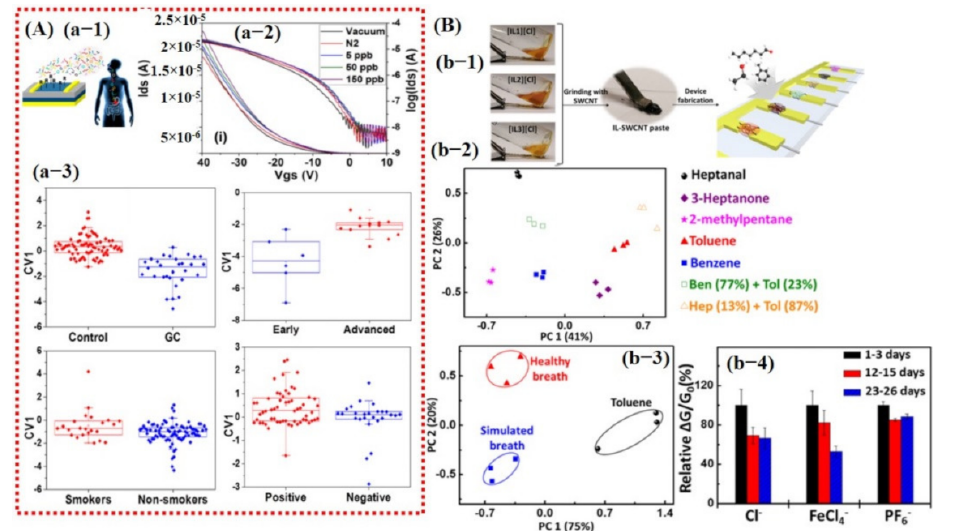
Figure 20. Smart breath analyzers using FET devices and machine learning: ( A ) Surface-modified single Si NW FET device for cancer detection: (a-1) Schematic diagram of fabricated sensor. (a- 2) Variation in IDS curve upon exposure to the increasing concentrations of VOCs. (a-3) CV1 values resulting from DFA analysis of the breath samples gastric cancer vs. control, early stages vs. advanced stages, smokers vs. nonsmokers, H. pylori-positive vs. H. pylori-negative. Reproduced with permission from [141], copyright 2015 ACS. ( B ) Ionic liquid-functionalized CNT-based FET sensing array was used for detection of different VOCs: (b-1) Schematic diagram of a fabricated array. (b-2,3) PCA results towards different VOCs. (b-4) The stability of ionic liquid after several days. Reproduced with permission from [149], copyright 2018